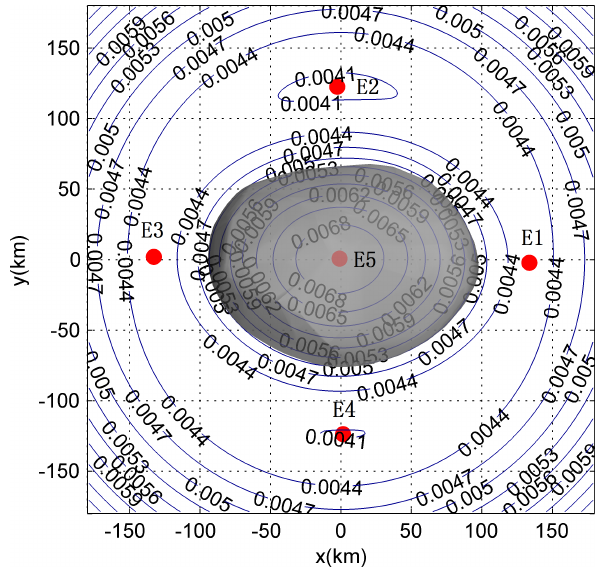
w=w/1.0 Figure 3. Zero-velocity curves and projections of equilibrium points in the equatorial plane (z=0). Table 1. Positions of the equilibrium points around 22